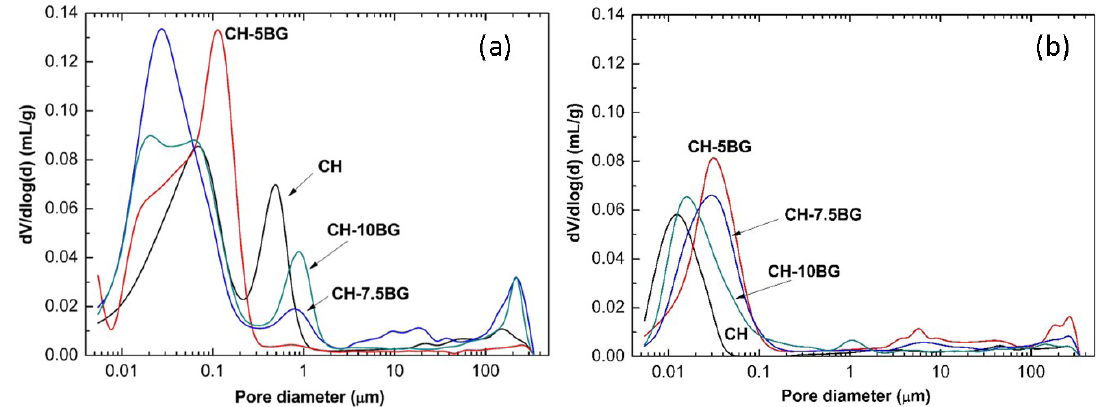
Figure 2. Pore size distribution (a) without or (b) with SBF treatment for blends based on homogeneous calcium aluminate cement (CH) containing different contents of bioactive glass